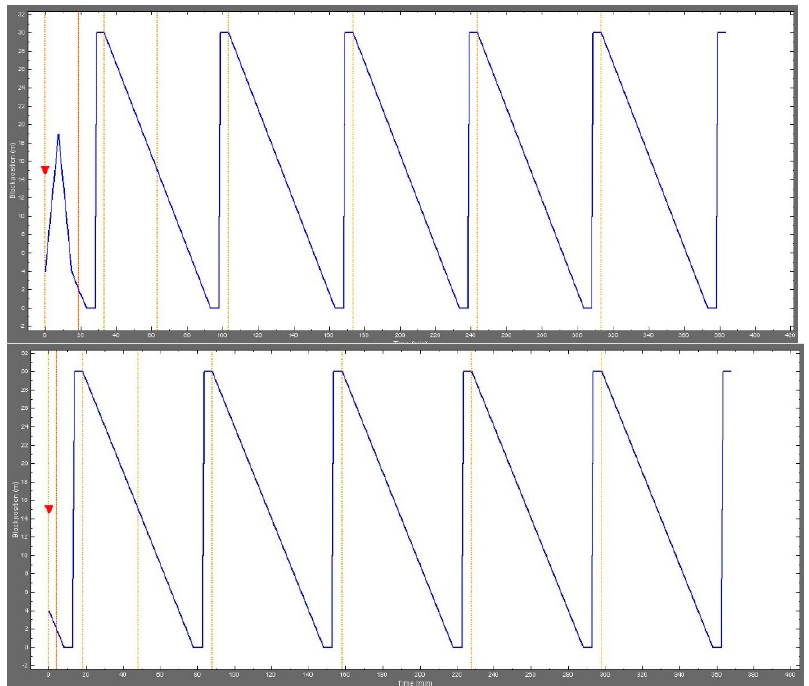
Figure 13. The action plans as suggested by the system for the two initial conditions from Figure 12. In the first case, a reciprocation sequence is recommended, while it is not deemed necessary in the second case.